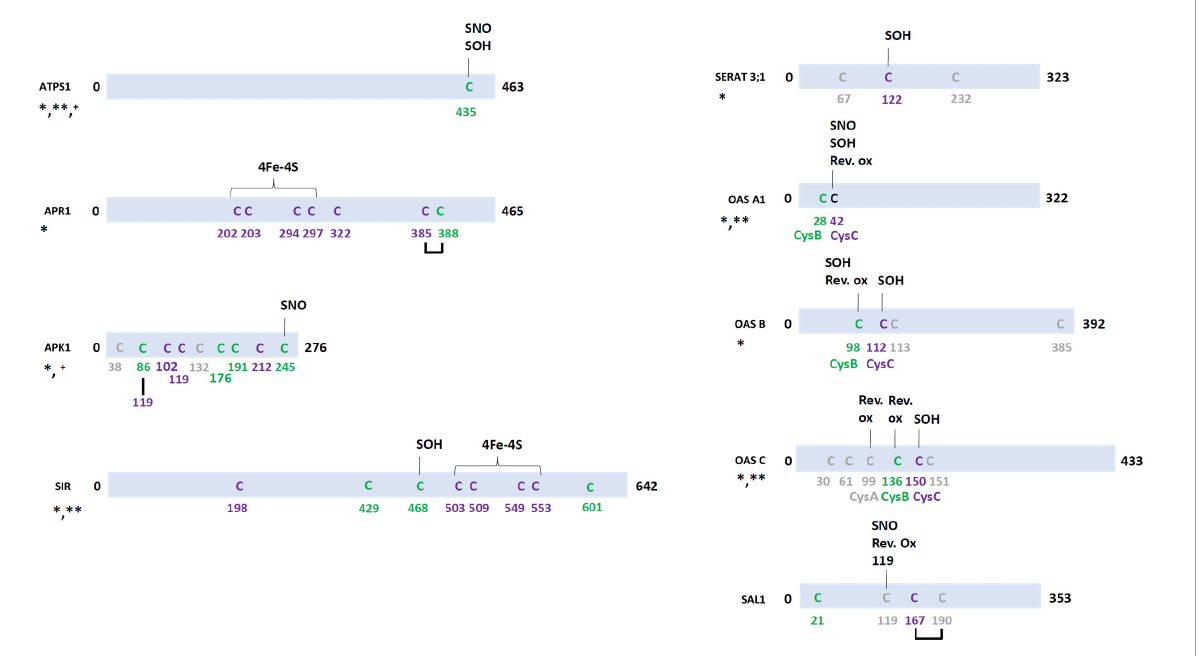
FIGURE2 Redox post-translational modifications of enzymes involved in sulfate assimilation pathway in the green lineage. In purple, cysteines conserved in all Arabidopsis isoforms and in at least one isoform from Chlamydomonas reinhardtii (green alga), Physcomitrella patens (Bryophyte), Selaginella moellendorffii (Lycophyte), Oryza sativa (Monocot), Zea mays (Monocot), Glycine max (Annual eudicot), Brassica oleracea (Biennal eudicot), Solanum lycopersicum (Perennial), Populus trichocarpa (Perennial), and Vitis vinifera (Perennial). In green, cysteines conserved in all Arabidopsis isoforms and at least one isoform from other terrestrial plants. In gray, cysteines present in A. thaliana isoform but not conserved in isoforms from other plants. For nitrosylation (SNO), reversible cysteine oxidation (Rev. ox.) and sulfenylation (SOH), targeted cysteines are known and they are indicated on the scheme. When targeted cysteines are unknown, the following code applies: ∗ , persulfidation; ∗∗ , TRX target; + , glutathionylation. For OAS-TL isoforms, the nomenclature CysA, B and C refers to the text. The scheme is based on the indicated A. thaliana isoforms, but additional information for missing isoforms in multigene families are found in Supplementary Tables 2,3